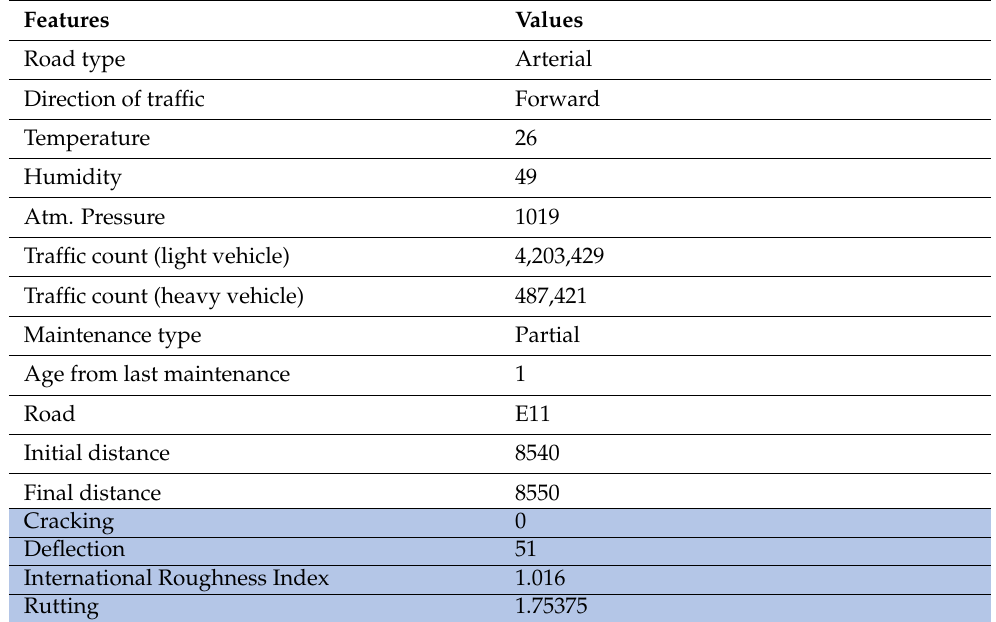
Figure 9. Bayesian network for road distress parameters, road factors, traffic factors and environmen- tal factors. Table 7. Datapoint selected for